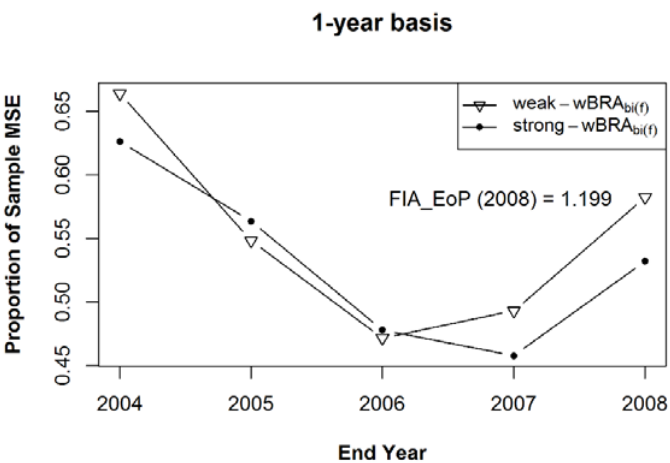
Figure 10. The mean bias ( a ) and the mean of Mean Squared Errors (( b ), expressed as a proportion of the MSE of the sample mean) for the bias-adjusted EoP Estimator wBRA bi ( f ) (for years 2004–2008), relative to Estimand 3, using the weak and strong prior samples, after 100 iterations of samples of size 1000 within the 125 populations of a composite sample of sample observation lengths of five, six, seven, eight, and nine years, in equal proportions.